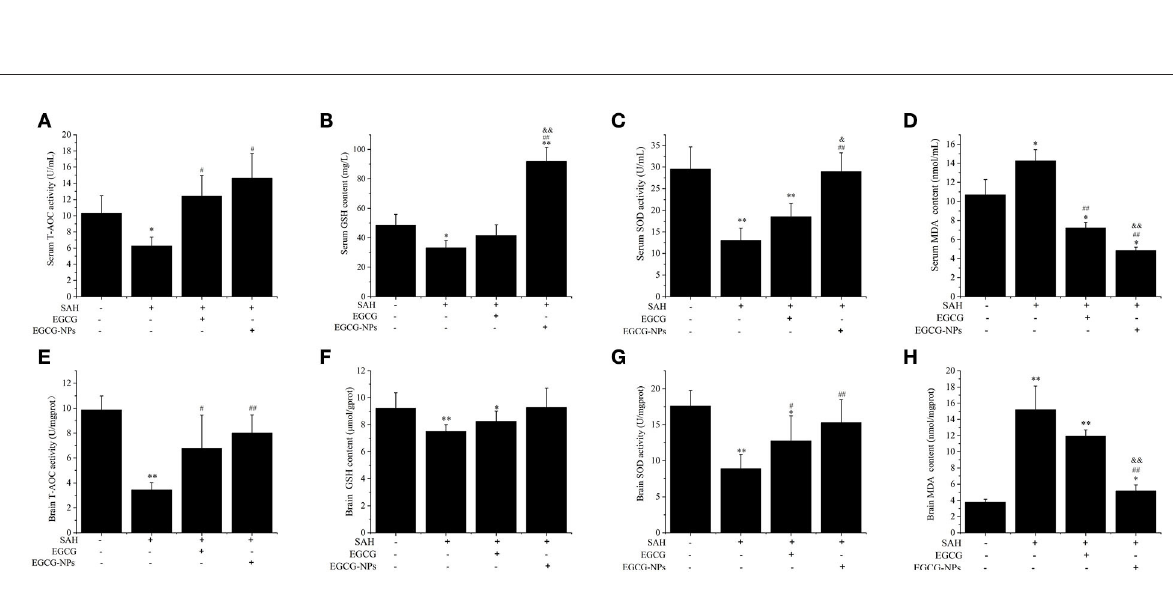
FIGURE4 Effects of EGCG-NPs on the regulation of antioxidative enzymes activities after SAH. Serum T-AOC, GSH, SOD activities, and MDA level, respectively (A–D) . T-AOC, GSH, SOD activities, and MDA levels in the brain, respectively (E–H) . Values represent three independent experiments. * P < 0.05 vs. Sham, ** P < 0.01 vs. Sham; # P < 0.05 vs. SAH, ## P < 0.01 vs. SAH; & P < 0.05 vs. EGCG, && P < 0.01 vs.